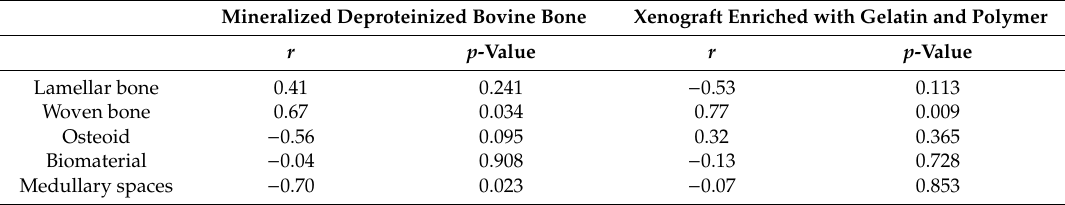
Table 1. Results of linear correlation between residual alveolar bone height (RBH) and each fraction for each group. Pearson correlation coefficients ( r ) are indicated.